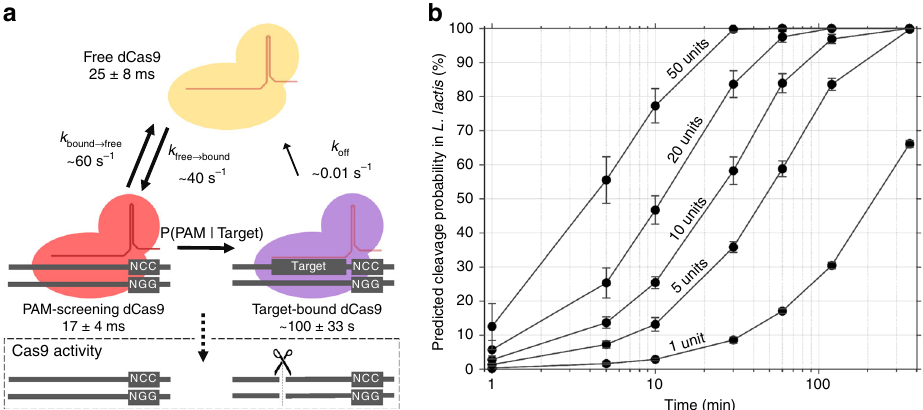
Fig. 4 Extrapolation of the dCas9 dynamic model to assess single target cleavage by Cas9. a The proposed model surrounding dCas9 interaction with the obtained kinetic rates. Free dCas9 (yellow) in the cytoplasm interact with PAM sequences (5 ’ -NGG-3 ’ ) on average every 25 ms. If the PAM is not in front of a target sequence (red), only PAM-screening will occur for on average 17 ms. If the PAM happens to be in front of a target, the dCas9 will be target- bound (purple). We extend this model to predict Cas9 cleavage under conditions where target-bound Cas9 will always cleave the target DNA. b Calculated predicted probability that a single target in the L. lactis genome is cleaved after a certain period of time with a certain cellular Cas9 copy number, based on the model shown in a. Error bars indicate standard deviation calculated from iterations of the